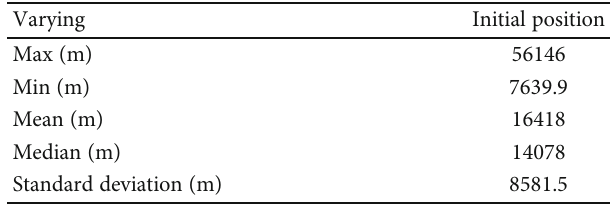
Figure 5: Monte Carlo simulation of nonlinear application in the Earth model varying initial positions. Table 6: Statistics of norm of fi nal missed distance for Monte Carlo simulation in the Earth model.